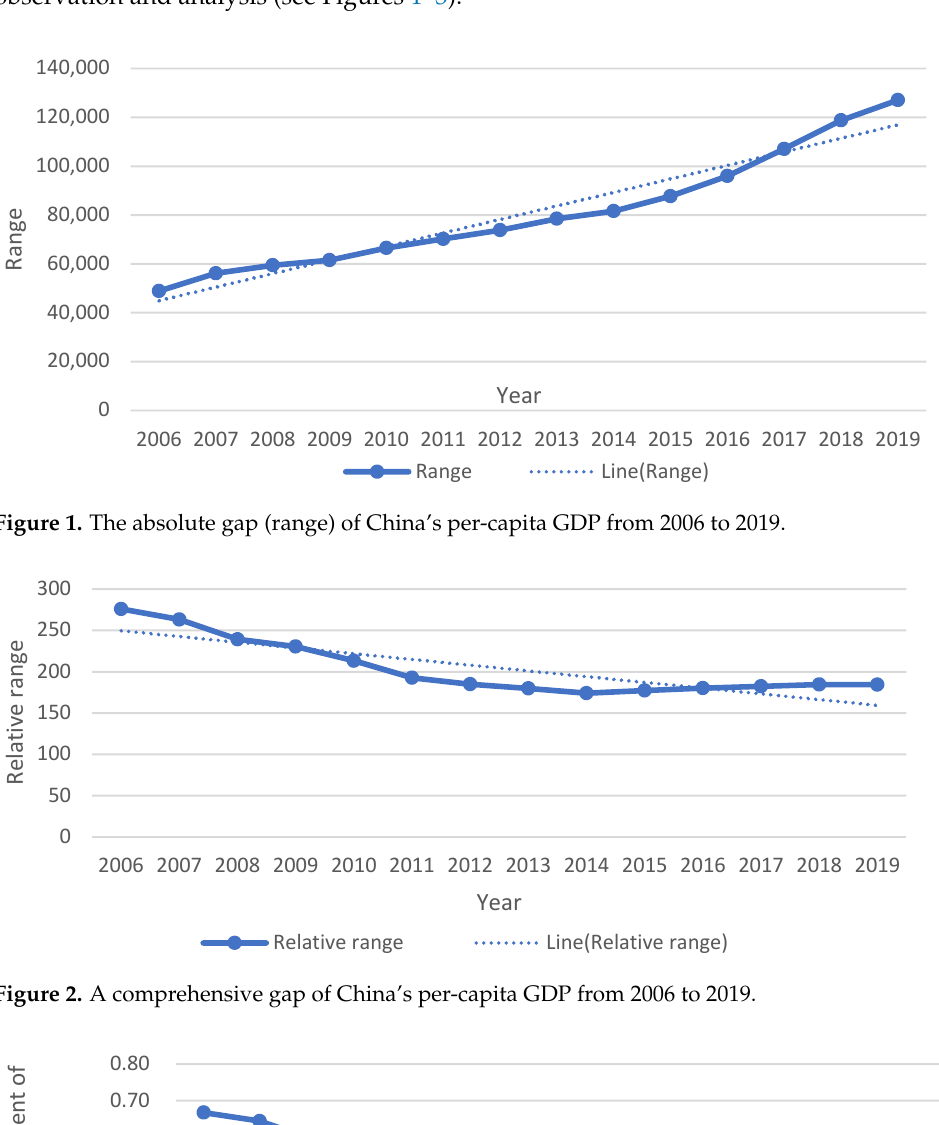
Figure 2. A comprehensive gap of China’s per-capita GDP from 2006 to 2019.